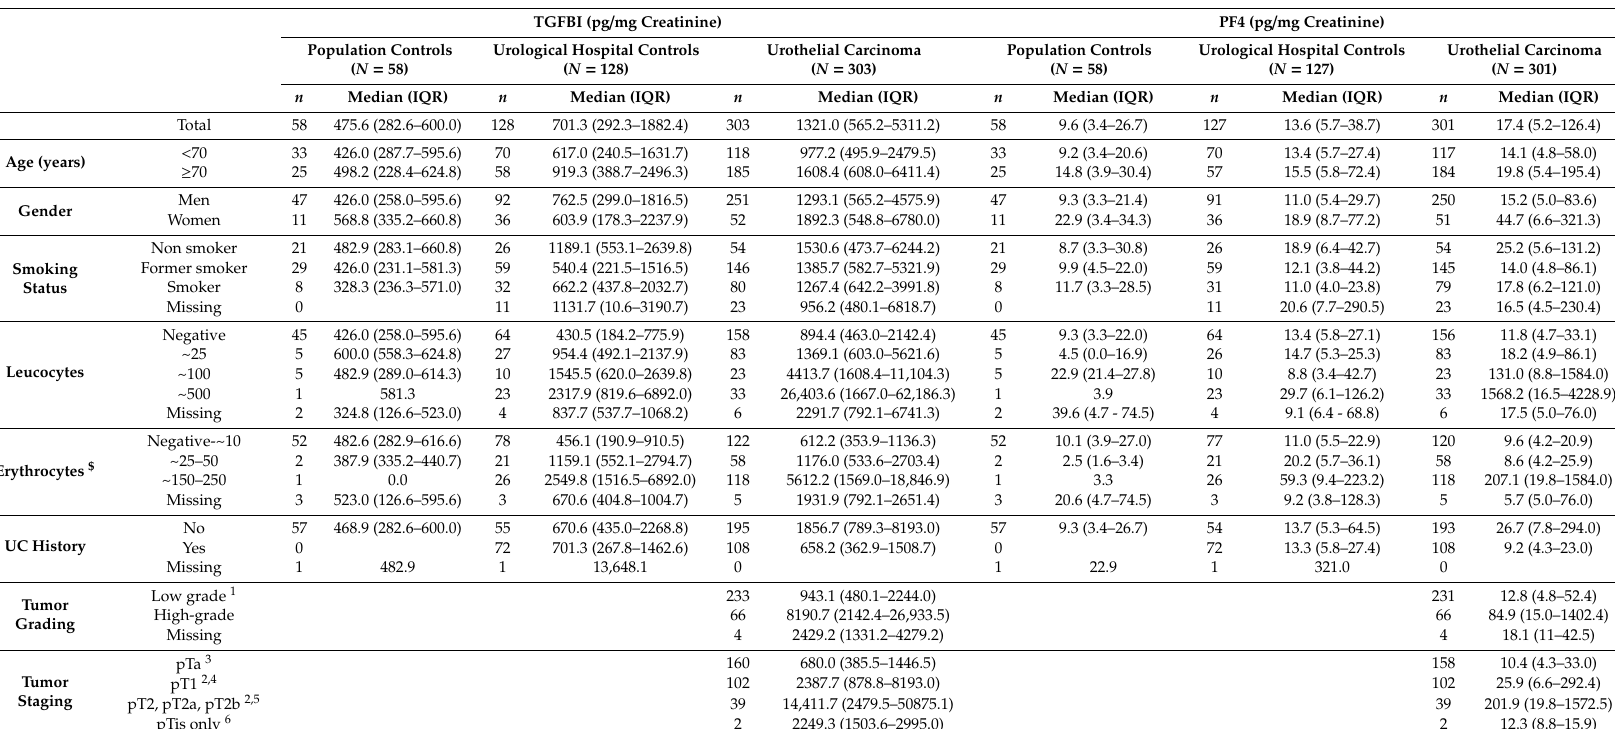
Table 1. Distribution of creatinine-normalized TGFBI and PF4 concentrations (in pg / mg creatinine) corresponding to individual sample characteristics for TGFBI ( n = 489) and PF4 ( n = 486). IQR, interquartile range; N , sample number; $ erythrocytes / µ L urine; 1 two tumors represent nested variants with bland cytomorphology but potentially poor outcomes; 2 one tumor represented a nested variant; 3 all low-grade; 4 71 out of 102 pT1 tumors (non-muscle invasive) were low-grade (69.6%); 5 2 out of 39 muscle invasive tumors were low-grade (5.1%); 6 all high-grade, as per